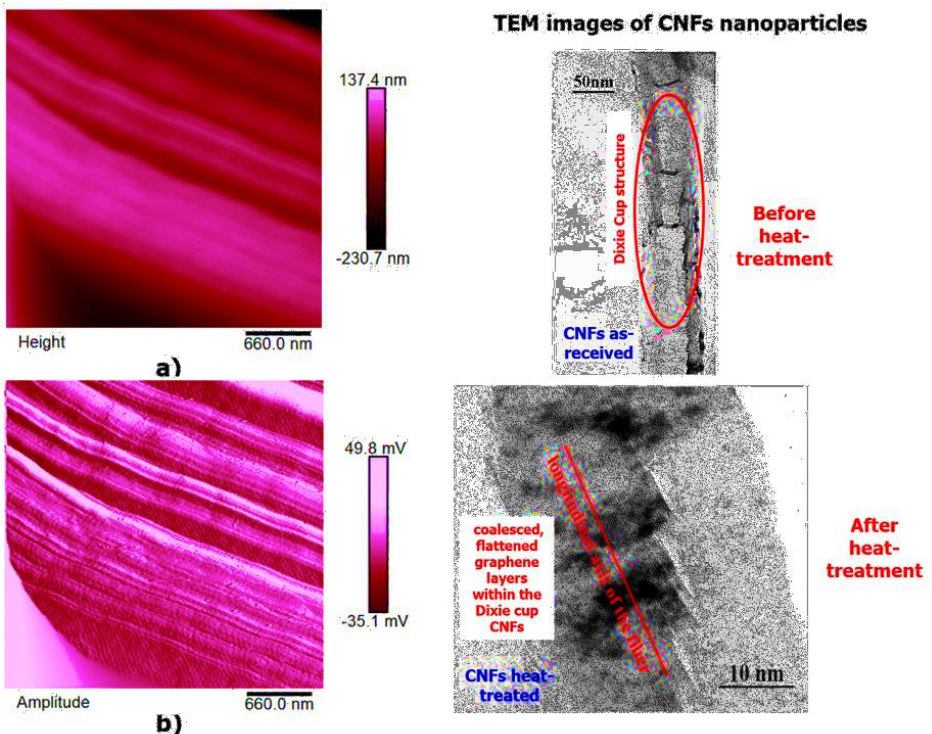
Figure 17. Tapping mode high-resolution AFM micrographs of the fracture surface of the TBD + 1%CNFs heat-treated sample (see on the left: ( a ) height profile, ( b ) amplitude profile) and the TEM micrographs of CNFs nanoparticles, before and after heat-treatment (see on the right).